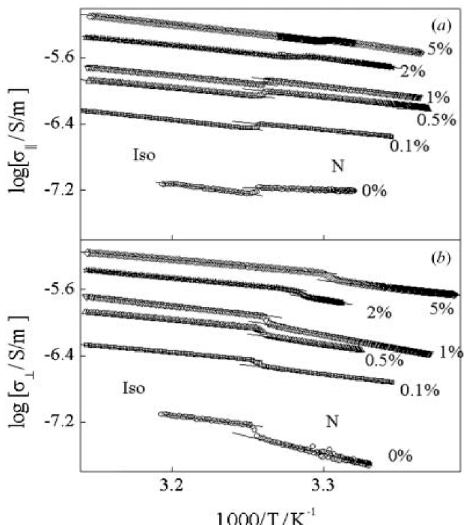
Figure 16. The temperature dependence of electrical conductivity in LC-CNT composites (in the nematic to isotropic phases) ( a ) along ( σ ‖ ) and ( b ) perpendicular ( σ ⊥ ) to the director for the pure compound and LC-gold nanoparticle (GNP) composites with different doping concentrations [49]. Several works have been done to increase the conductivity of discotic liquid crystals by metal NP doping. Prasad et al. reported a moderate increase in conductivity by doping with 20–50 wt.% of GNPs [90,91]. In their later work, by doping with 1.0 wt.% of 2.4 nm GNPs coated with a triphenylene derivate in columnar discotic HAT7, they observed an increase of 6 orders of magnitude in the conductivity [92]. However, none of these works mentioned the effect of an electric field. Holt et al. demonstrated a field-induced increase in the conductivity of a discotic liquid crystal doped with only 1.0 wt.% of GNPs [93]. They use GNPs coated with a methylbenzene thiol dopant in HAT6 and Hexadecane liquid crystals. For HAT6 mixing, 1.0 wt.% of GNPs increased the conductivity by two orders of magnitude in all three phases (solid crystal, columnar liquid crystal, and isotropic liquid). Moreover, in the isotropic phase (above 100 °C), applying an electric field above a certain threshold increases the conductivity another three to four orders of magnitude as shown in Figure 17a. However, this change is irreversible; conductivity does not change further even if you reduce, turn off, or even reverse the field, as shown in Figure 17b. Furthermore, in a cooling operation (from isotropic to LC phase to crystal phase), the high conductivity value is sustained. Similarly, in the case of a 1% GNP doping in hexadecane (Crystalline to isotropic phase transition temperature 18 °C), similar orders of magnitude of an increase in conductivity was found, but the change disappeared (reversible) in the transition from the isotropic to crystalline phases (during cooling cycle). In both cases (HAT6/GNP and Hexadecane/GNP), conductive pathways are formed upon applying a sufficiently large electric field between the electrodes of LC cell, which is evident form the observation of the aggregation of nanoparticles in their interdigitated electrode experiments [93]. Here, the concentration of GNPs is well below the percolation limit, so the formation of conductive pathway is only possible by the field-induced organization of nanoparticles [94–96]. A possible explanation is GNPs moves in the electric field by electrophoresis, or an even field can also polarize the particles. This induces the self-assembly of particles (i.e., GNPs) by dipole–dipole interactions. This happened specially in the isotropic phase as LC shows a low viscosity, which eases the movement of GNPs. During crystallization. HAT6 can preserve the high conductivity, but the hexadecane composite cannot, as mention earlier. This is because, in the case of HAT6 during the cooling operation, homogeneously aligned grain boundaries are formed perpendicular to the electrodes, whereas in the case of hexadecane, grain boundaries are formed in a random orientation which disrupts the conductive GNP chains. Their major conclusion is that the orientational ordering of the LC molecules